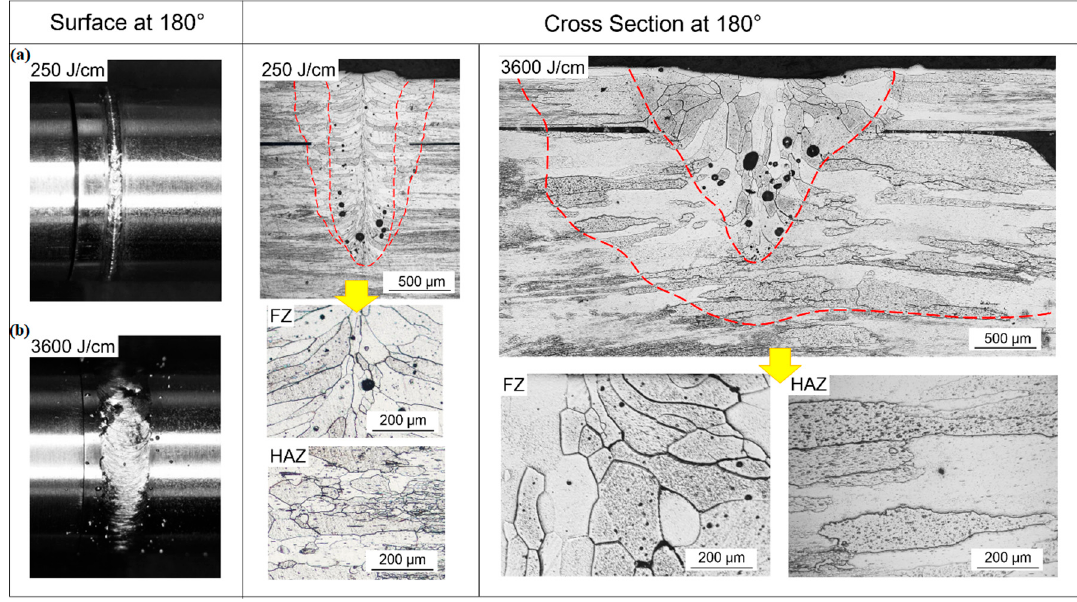
Figure 5. The surface morphology and cross section of NS-Mo alloy joints achieved at the heat input of: ( a ) 250 J / cm; ( b ) 3600 J /